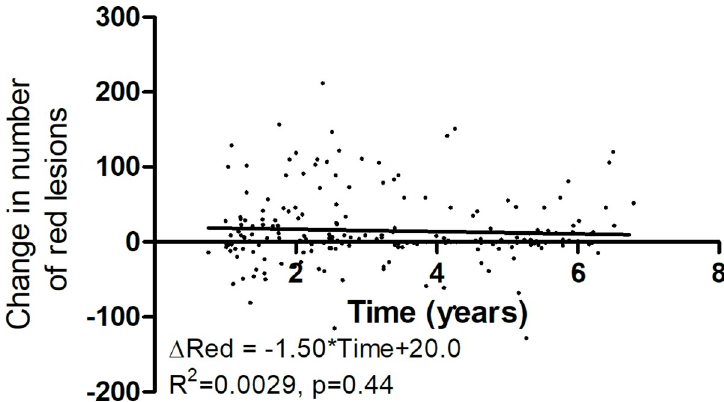
Fig 3. The change in red lesion count. Plotted as a function of follow-up time. There was no significant change in red lesions with time.